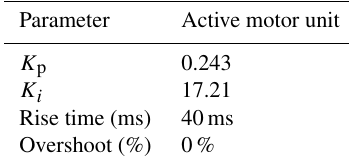
Table 2. Controllers